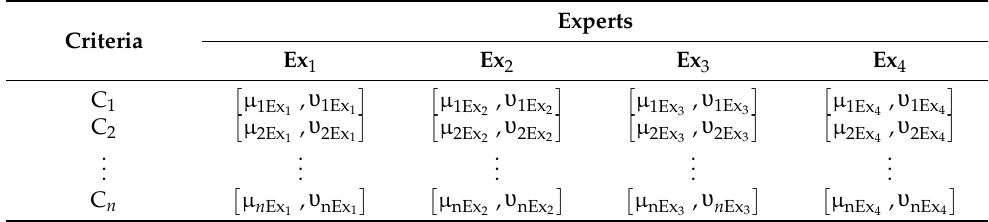
Table 2. The evaluation matrix for criteria based on q-ROFN with respect to